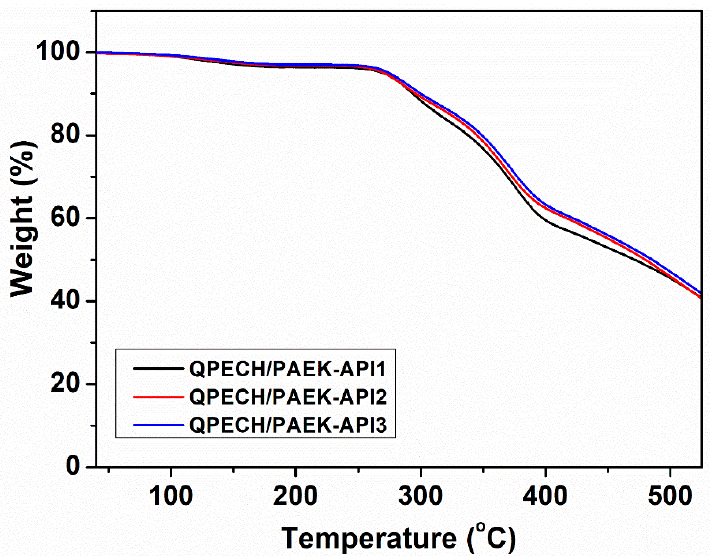
Figure 6. TGA behavior of QPECH/PAEK-API membranes.